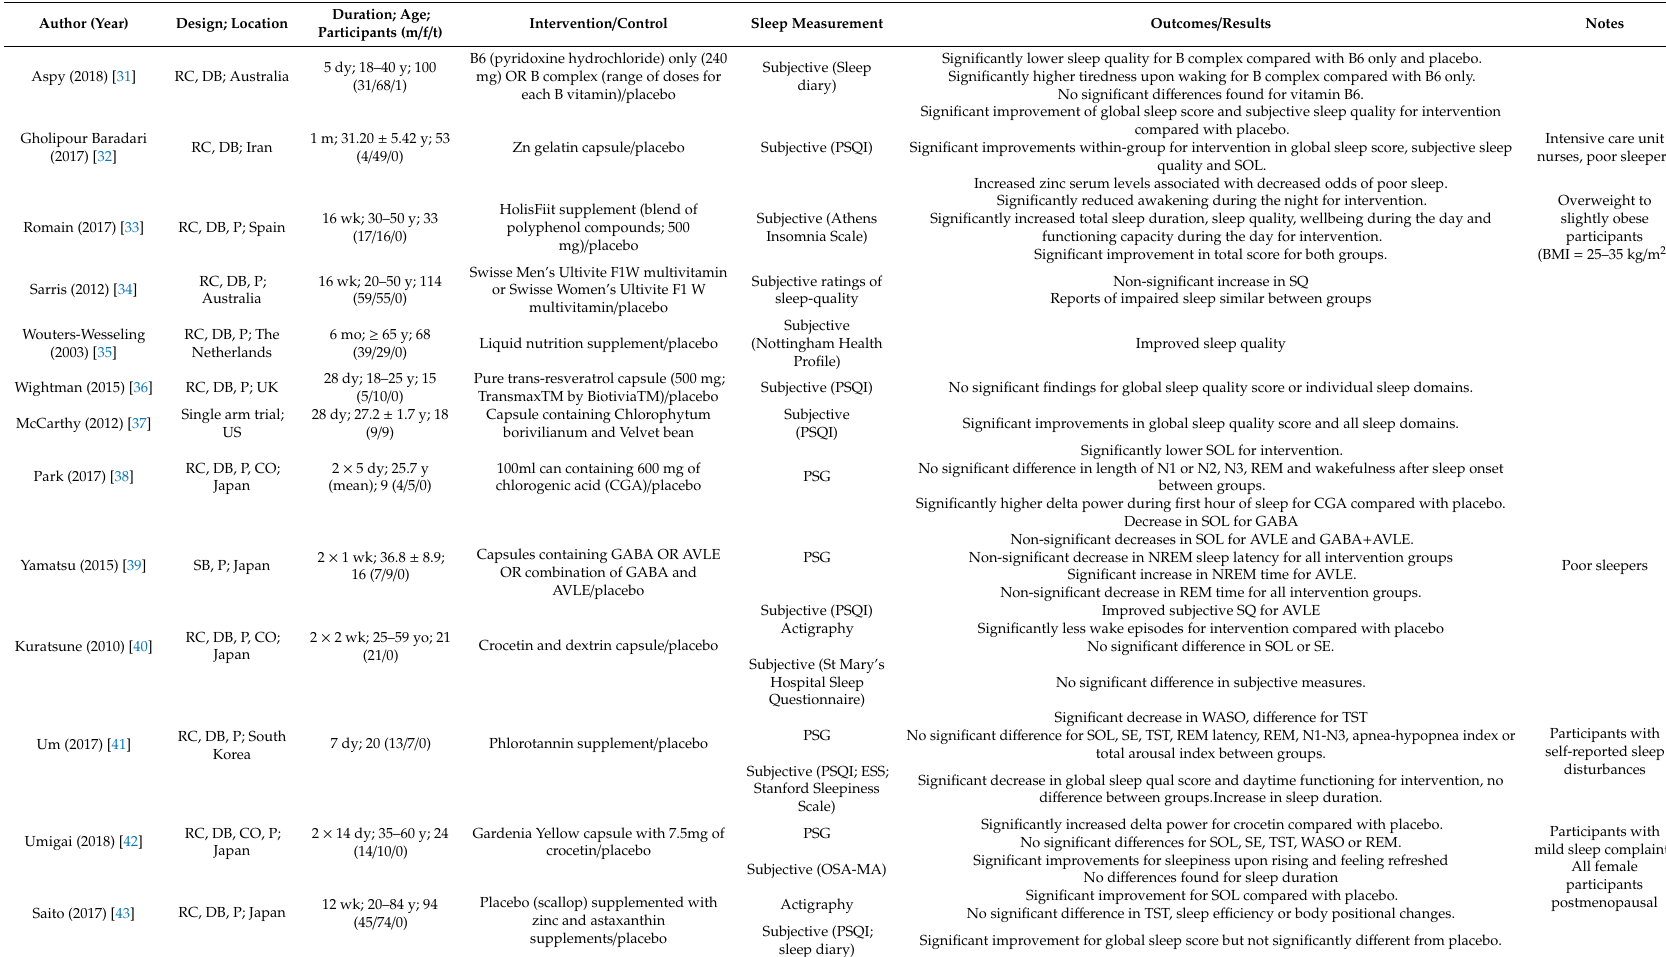
Table 2. The study characteristics and outcomes for the investigations between dietary supplements and